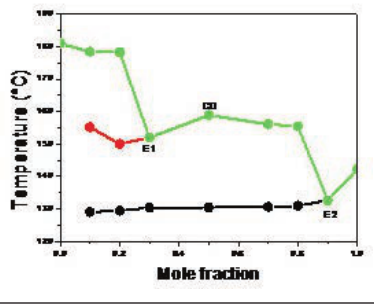
Figure 3. AS-AQ phase diagram. TA=Melting temperature of AQ TB= Melting temperature of AS TC=Melting temperature of Cocrystal, E1,E2=Eutectic point,SA=Solid of component AQ, SB=Solid of component AS, SC=Solid of component Cocrystal, L= Liquid.